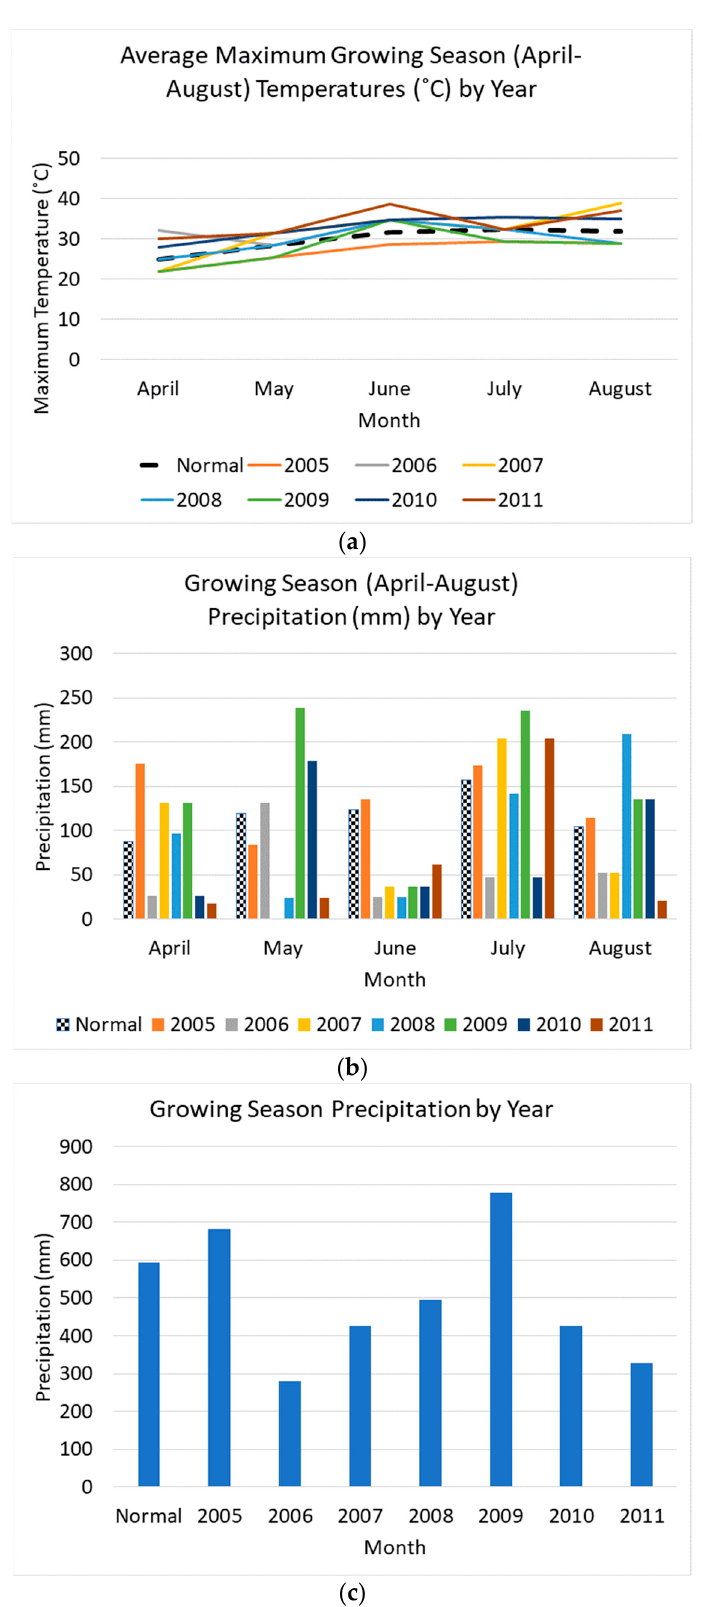
Figure 3. Graphs showing normal and growing season (April–August) ( a ) maximum temperatures (Tmax, °C) (accuracy ± 2 °C), ( b ) monthly precipitation (mm) (±50 mm) and ( c ) growing season precipitation (mm) for Enterprise, AL in 2005–2011.